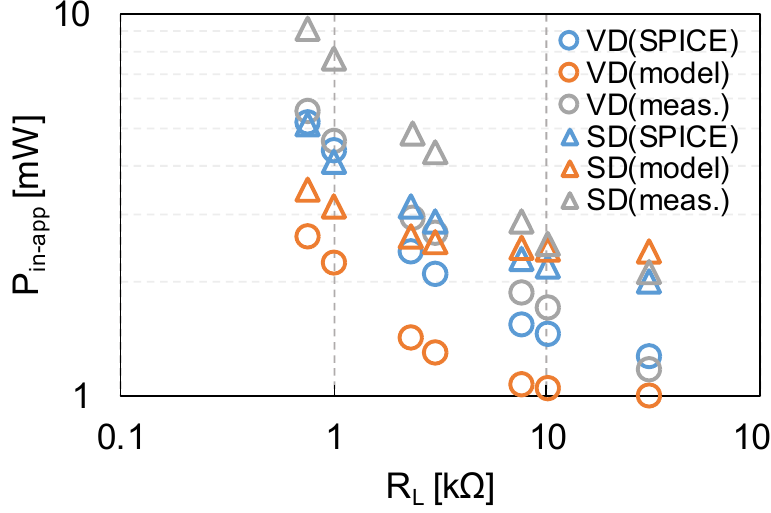
Figure 22. Input apparent power vs. load resistance R L